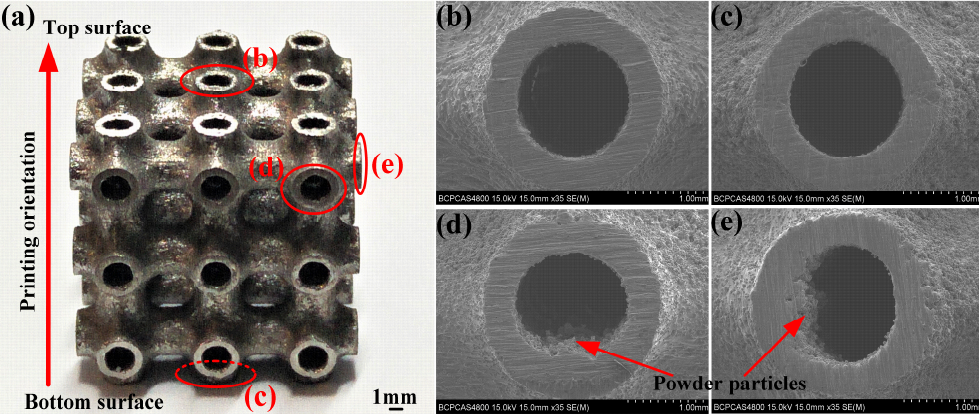
Figure 2. Macro- and micro-observations: ( a ) printed specimen HT, ( b ) top local surface, ( c ) bottom local surface, and ( d , e ) side local surfaces.